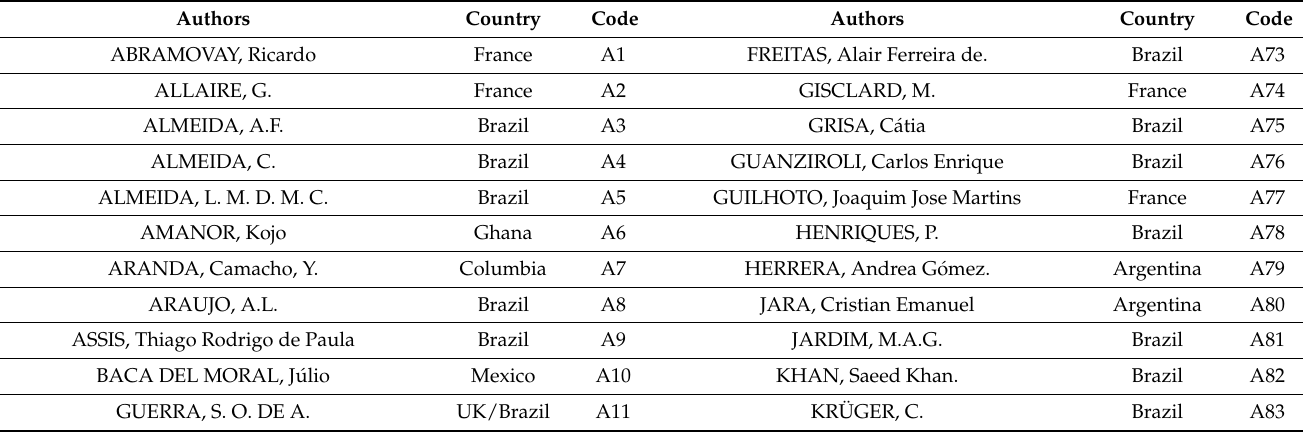
Table A1. Authors and corresponding